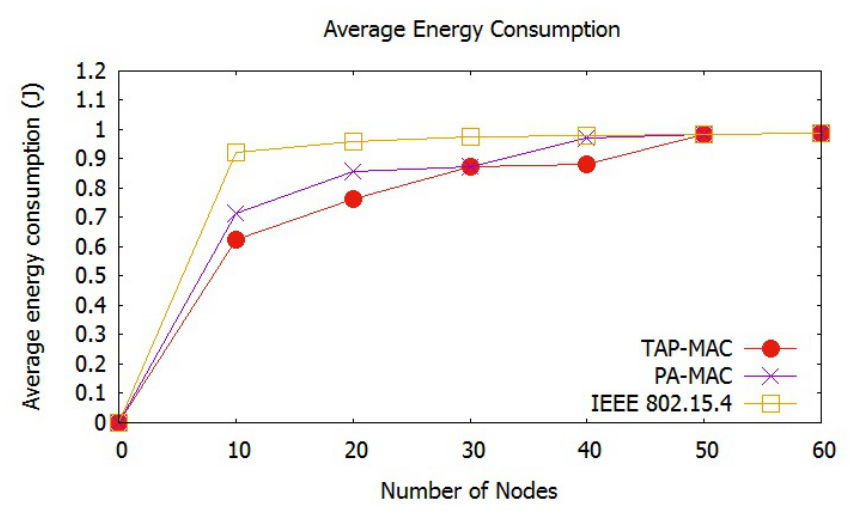
Figure 13. Scenario 2: Average energy